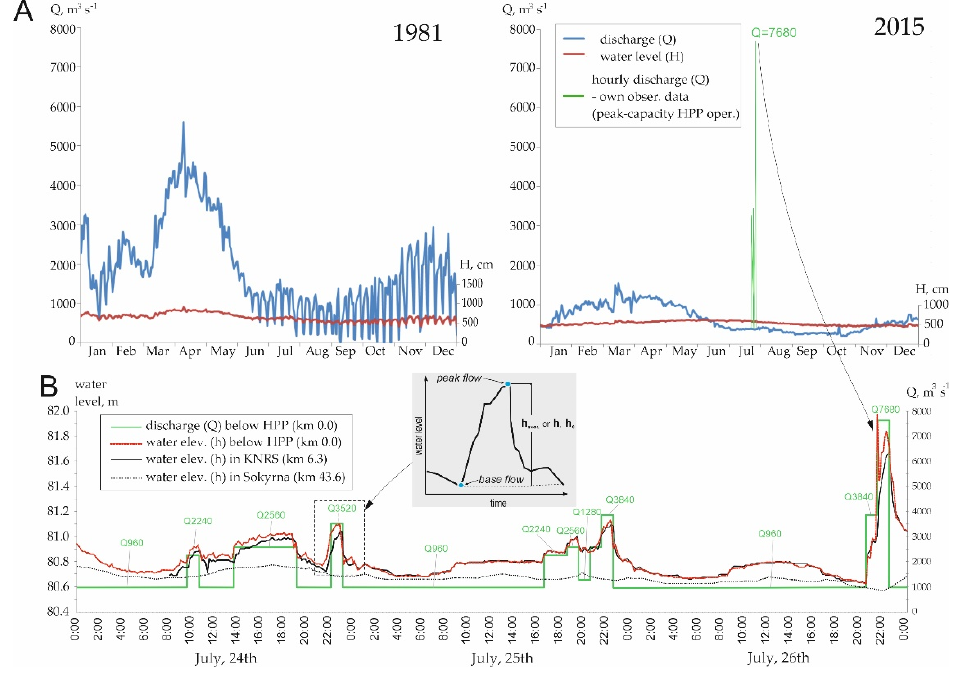
Figure 2. Examples of the Dnieper River daily hydrographs at Kaniv gauging station ( A ) under different operating regimes (1981—hydropeaking regime, 2015—run-of-river and peak-capacity type regime) [55] as well as ( B ) the hydrograph of water elevation and discharge during HPP peak-capacity operation in June 2015.